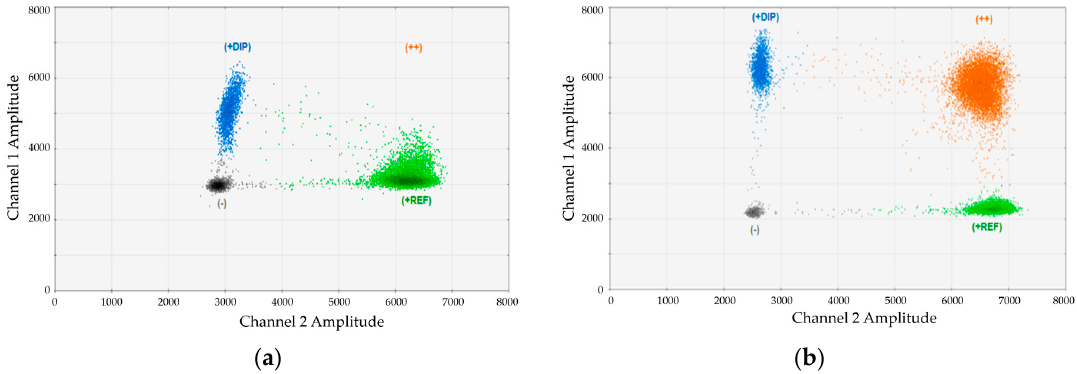
Figure 1. Adjustment of MgCl 2 concentration results in substantially improved cluster separation in digital-PCR (dPCR) duplex assays: ( a ) duplex-assay DP134-I (channel 1, FAM) + REF (reference; channel 2, HEX) with the standard concentration of MgCl 2 contained in the Bio-Rad buffer. No separation of double and single HEX-positive signals; and ( b ) the same duplex assay DP134-I + REF with optimized MgCl 2 concentration.